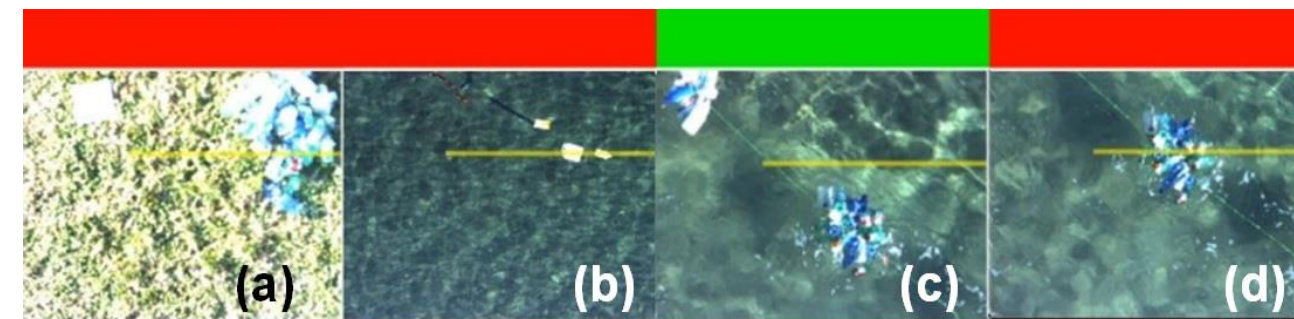
Figure 16. Snapshots from real-time detection. Yellow lines indicate the position and field-of-view of the hyperspectral sensor line, relative to the visible image. A red or green bar indicates positive or negative response of the plastics detector, respectively. ( a ) PET bottles on grass; ( b ) Platamona; ( c , d ) Porto Ferro.